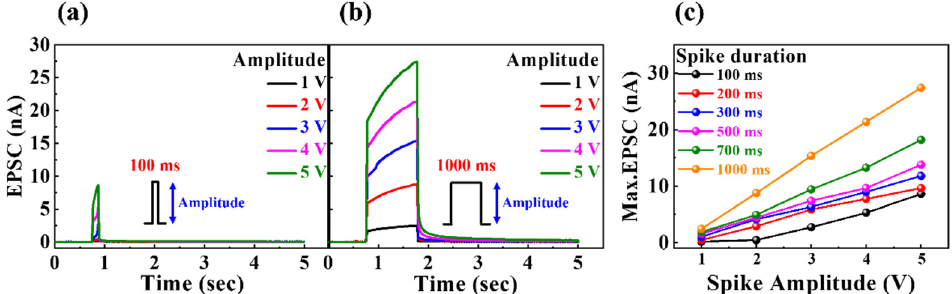
Figure 5. Single-spike EPSC curves of the milk–Ta 2 O 5 hybrid crossbar array memristors with pulse duration of ( a ) 100 ms and ( b ) 1000 ms for pulse amplitudes of 1–5 V. ( c ) Maximum EPSC for various spike amplitudes and durations.